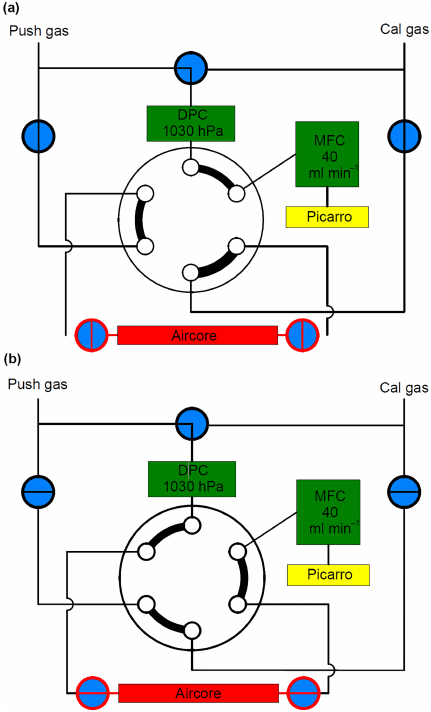
Figure 2. Analytical set-up for the measurement of AirCore. The AirCore including the valves which are flown is shown in red. In the bypass/flushing position (a) the push gas (PG) is measured bypass- ing the AirCore. The transfer lines to the AirCore can be flushed with PG or with a calibration standard (Cal Gas), allowing us to connect the AirCore to the analytical system without contamina- tion. For the analysis the transfer lines to the AirCore are closed, the AirCore valves are opened and the two position valve is switched to the measurements mode (b) . The PG is passed through the AirCore and pushes the air to the Picarro. Pressure and flow are controlled allowing for a very constant air flow.